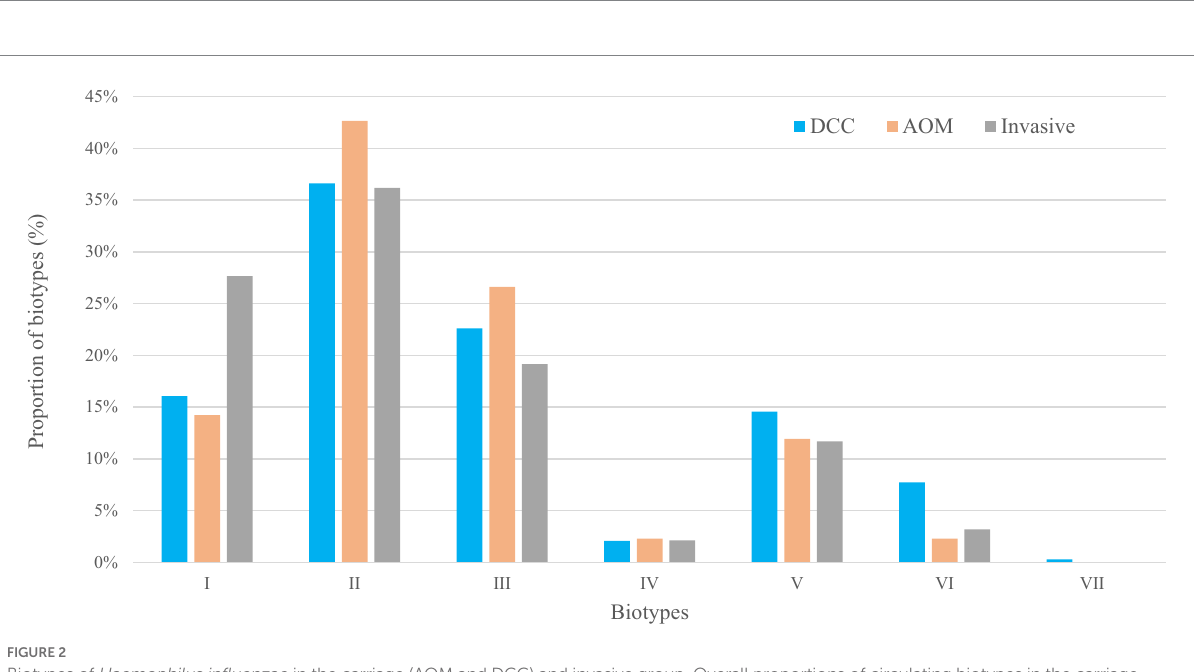
From the 554 samples from the carriage group, 129 resistant or “less” susceptible strains were reanalyzed and were checked on mutations in the ftsI gene. In 81.0% (104/129) of the strains, a mutation in the ftsI gene was found. No difference was observed in the